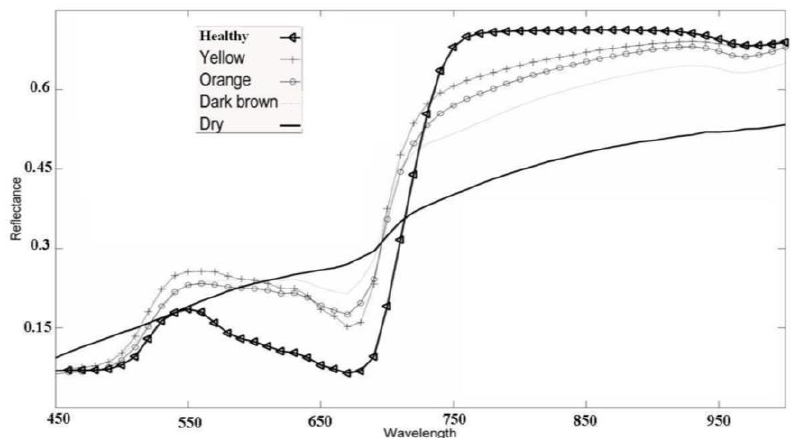
Figure 3. Estimated reflectance spectra of healthy leaf and all other disease symptoms of wheat leaf